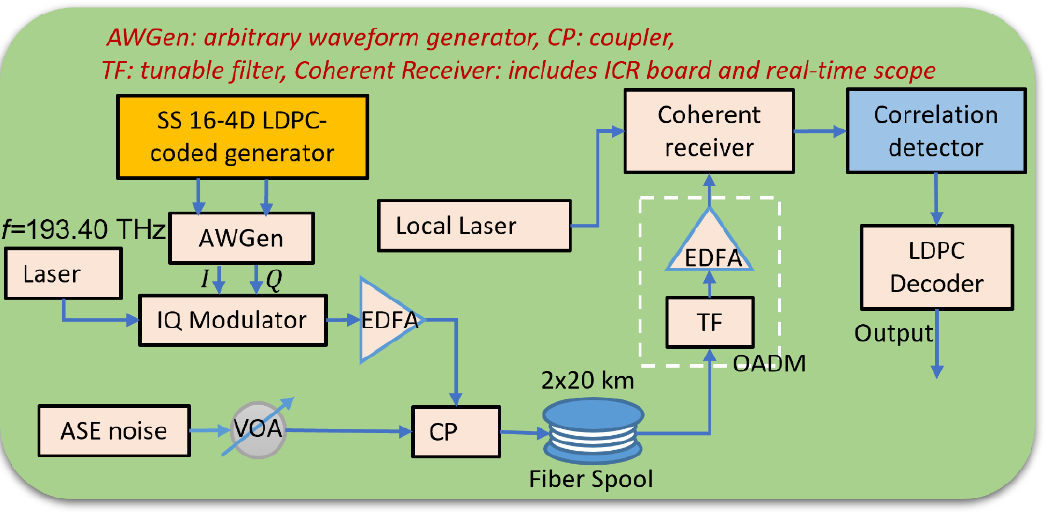
Figure 3. Experimental setup for SS-based 16-4D LDPC coded modulation scheme. OADM: optical add-drop multiplexer emulator.